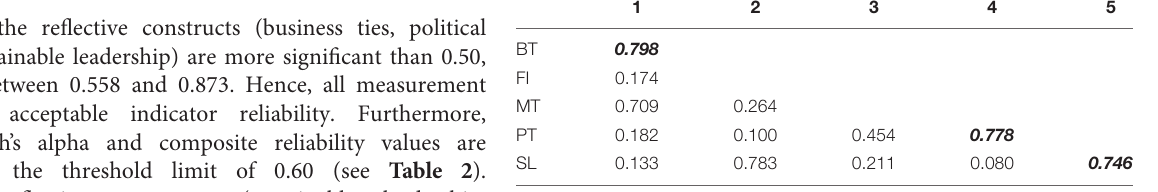
Bold and italic values refer to the square root of their corresponding AVE